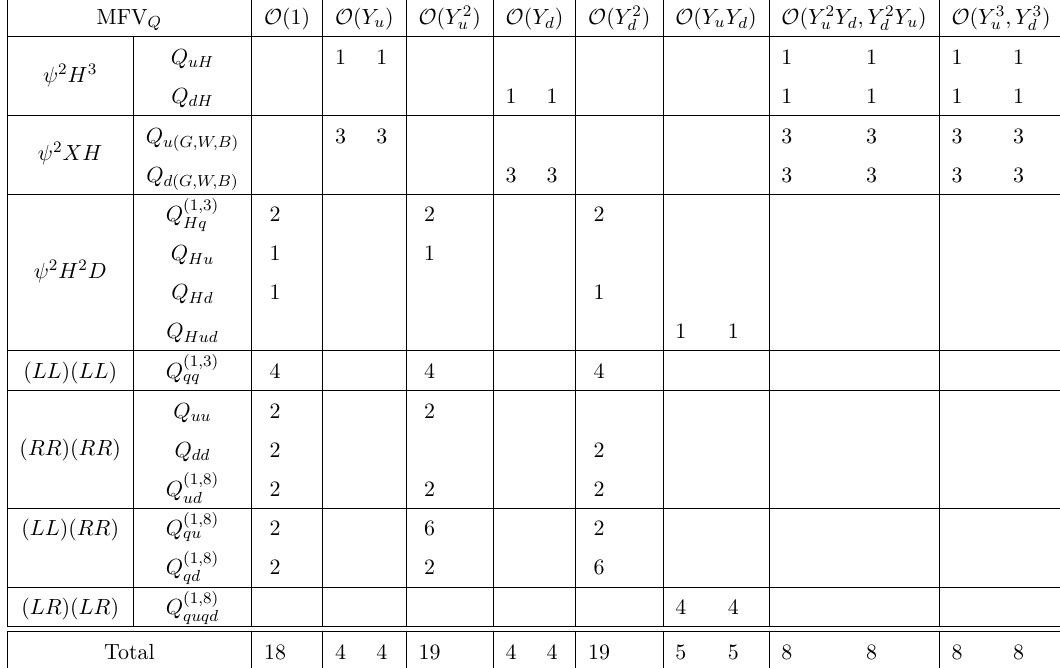
Table 6 . Counting of the pure quark SMEFT operators (see appendix A) assuming MFV symmetry in the quark sector and taking the combinations up to three insertions of Y u and Y d spurions in the decompositions. The left (right) entry in each column gives the number of CP even (odd) coefficients at the given order in spurion